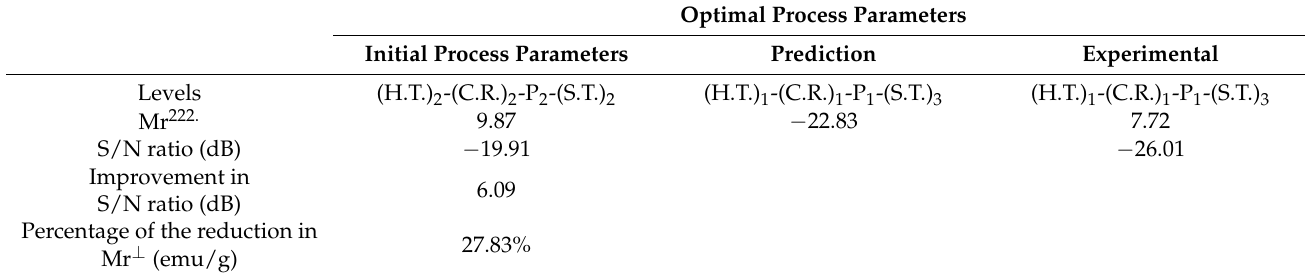
Table 8. Confirmation test results for Mr ⊥